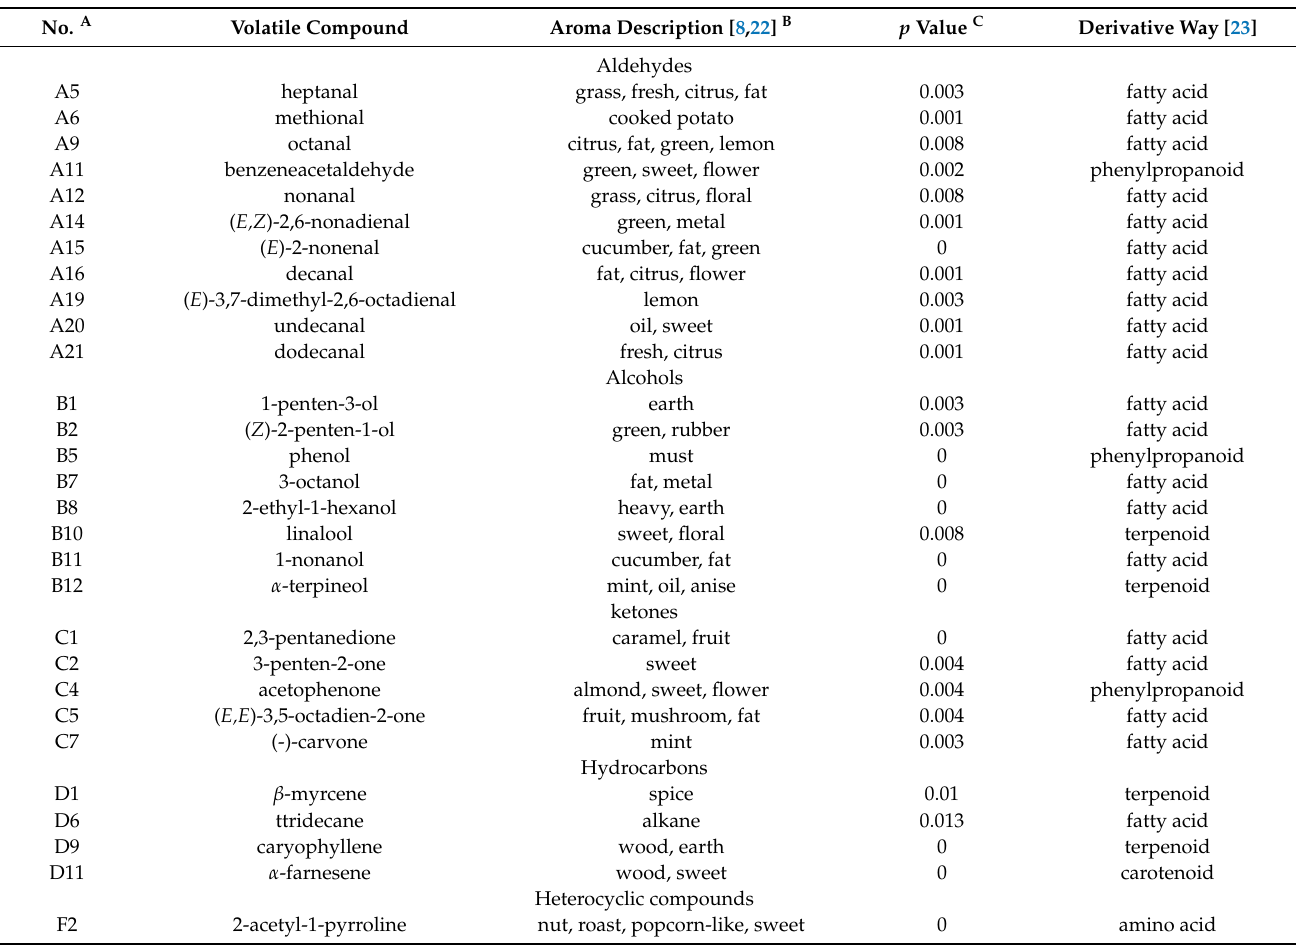
A The No. refer to the order in Table 1. B The aroma description also refers to http://www.flavornet.org/d_odors.html (accessed on 15 January 2021). C The p value was calculated using ‘SPSS 17 (cid:48)